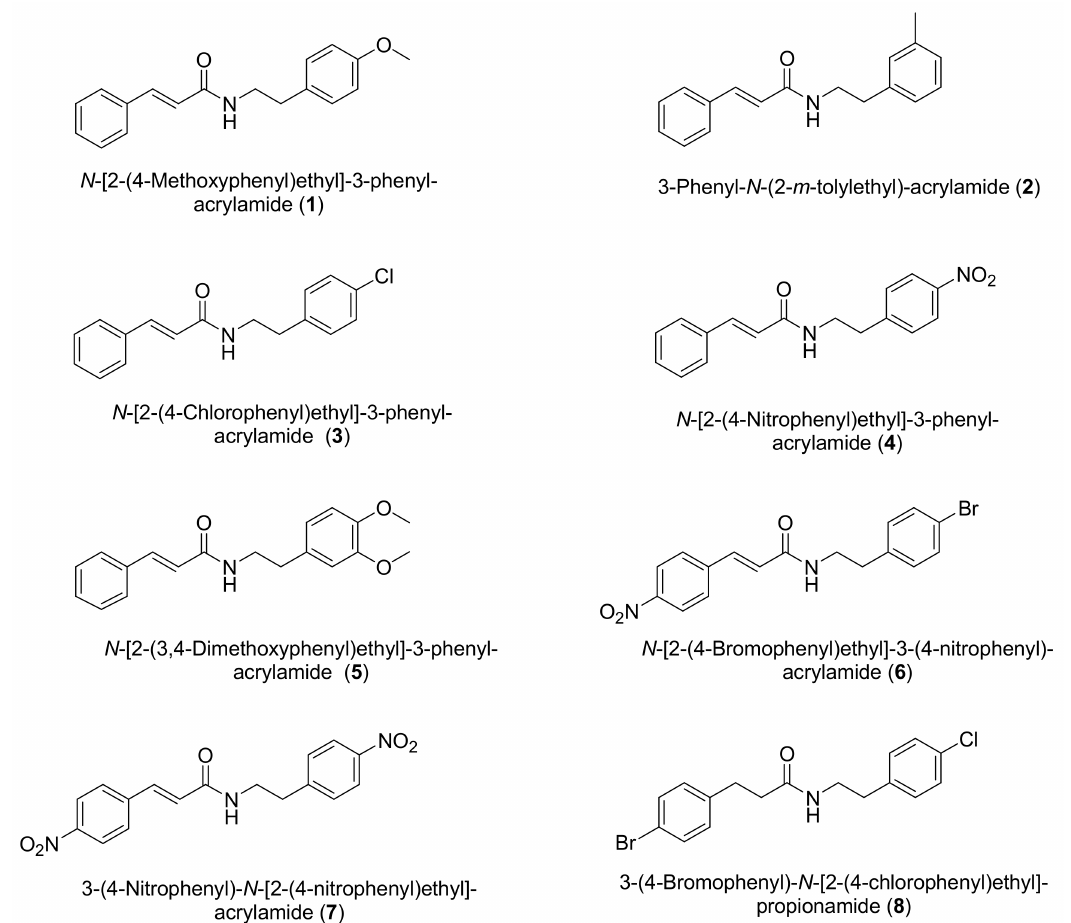
Figure 1. Chemical structure of compounds 1 – 8